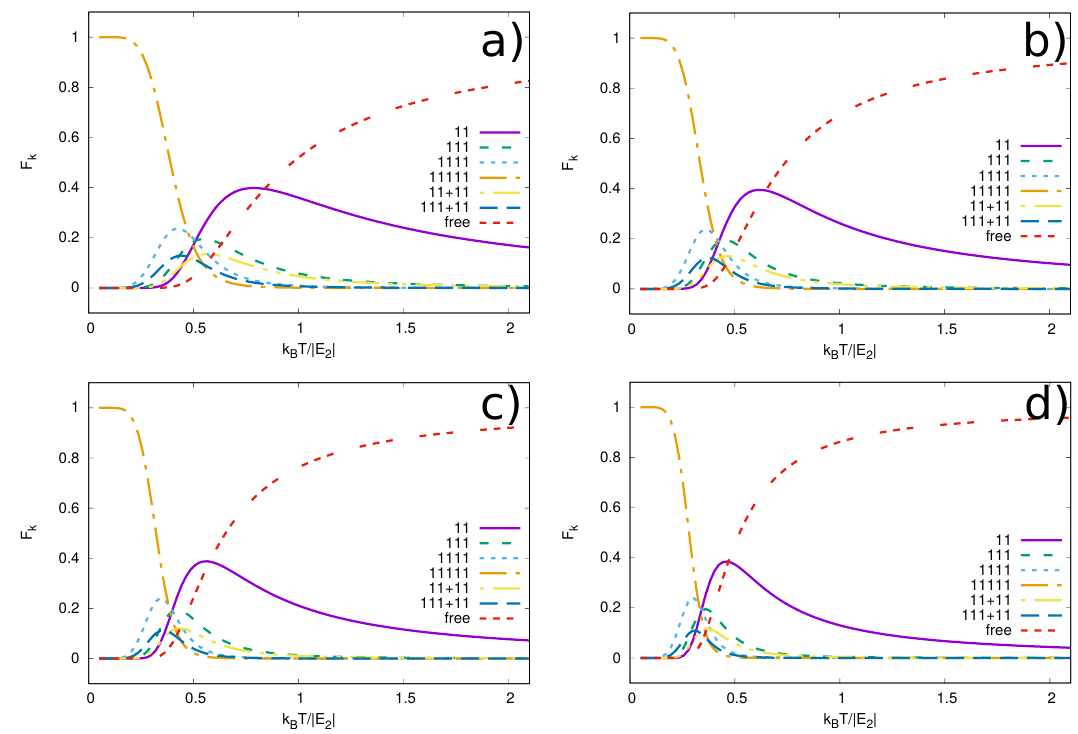
Figure 6. Fractional occupancies of different clusters as a function of temperature for a system of five 1D layers each with one particle. ( a ): The confining frequency is chosen such that the oscillator length in the tubes is equal to twice the inter-layer distance. The dipole strength is U = 5. ( b ): The confining frequency is chosen such that the oscillator length in the tubes is equal to twice the inter-layer distance. The dipole strength is U = 8. ( c ) The dipole strength is U = 5, and the confining frequency is chosen √ such that the oscillator length in the tubes is equal to 10 the inter-layer distance. ( d ): The dipole strength is U = 8 and the confining frequency is that same as in panel ( c